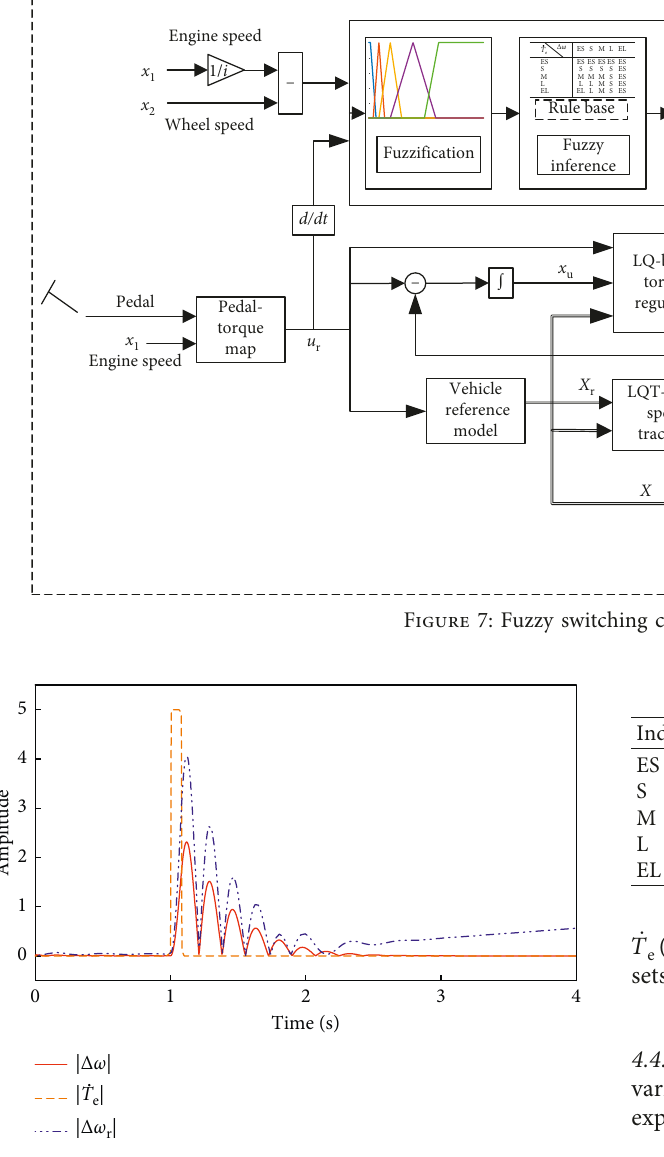
Figure 8: Acceleration without vibration control.